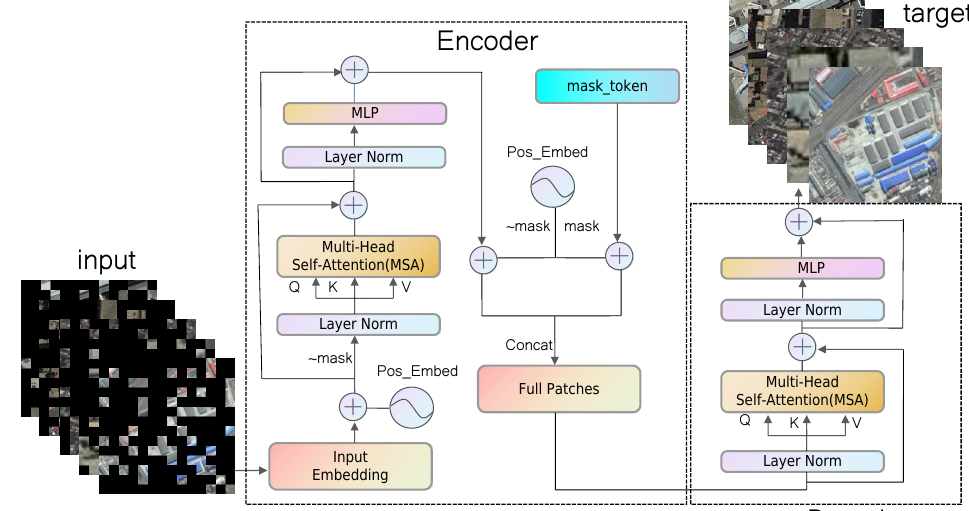
Figure 1. The overall architecture of the self-supervised learning